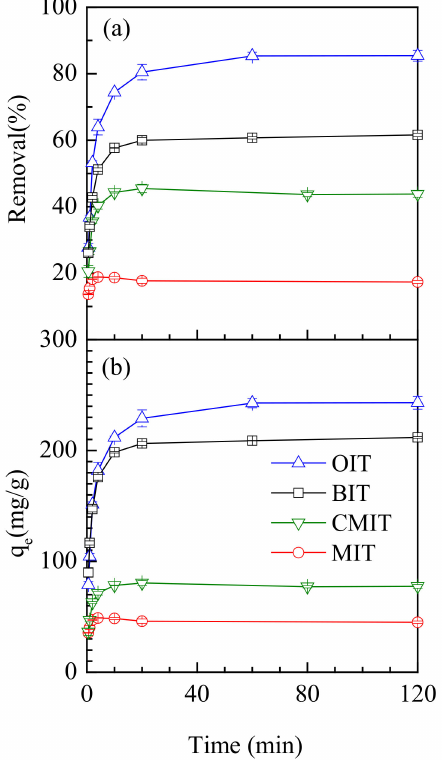
Figure 1. Effect of adsorption time on the removal of isothiazolones ( a ) and adsorption amounts ( b ) at 298 K with a PAC dose of 100 mg · L − 1 .